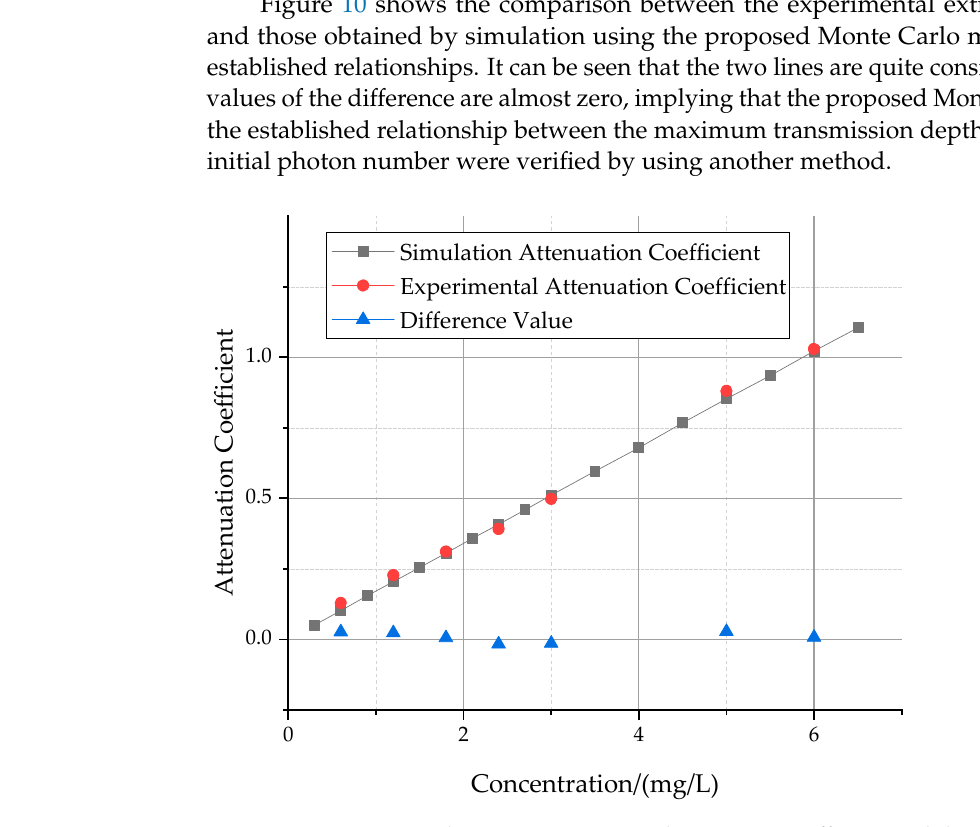
Figure 10. Comparison between experimental extinction coefficient and those obtained by Monte Carlo simulation.